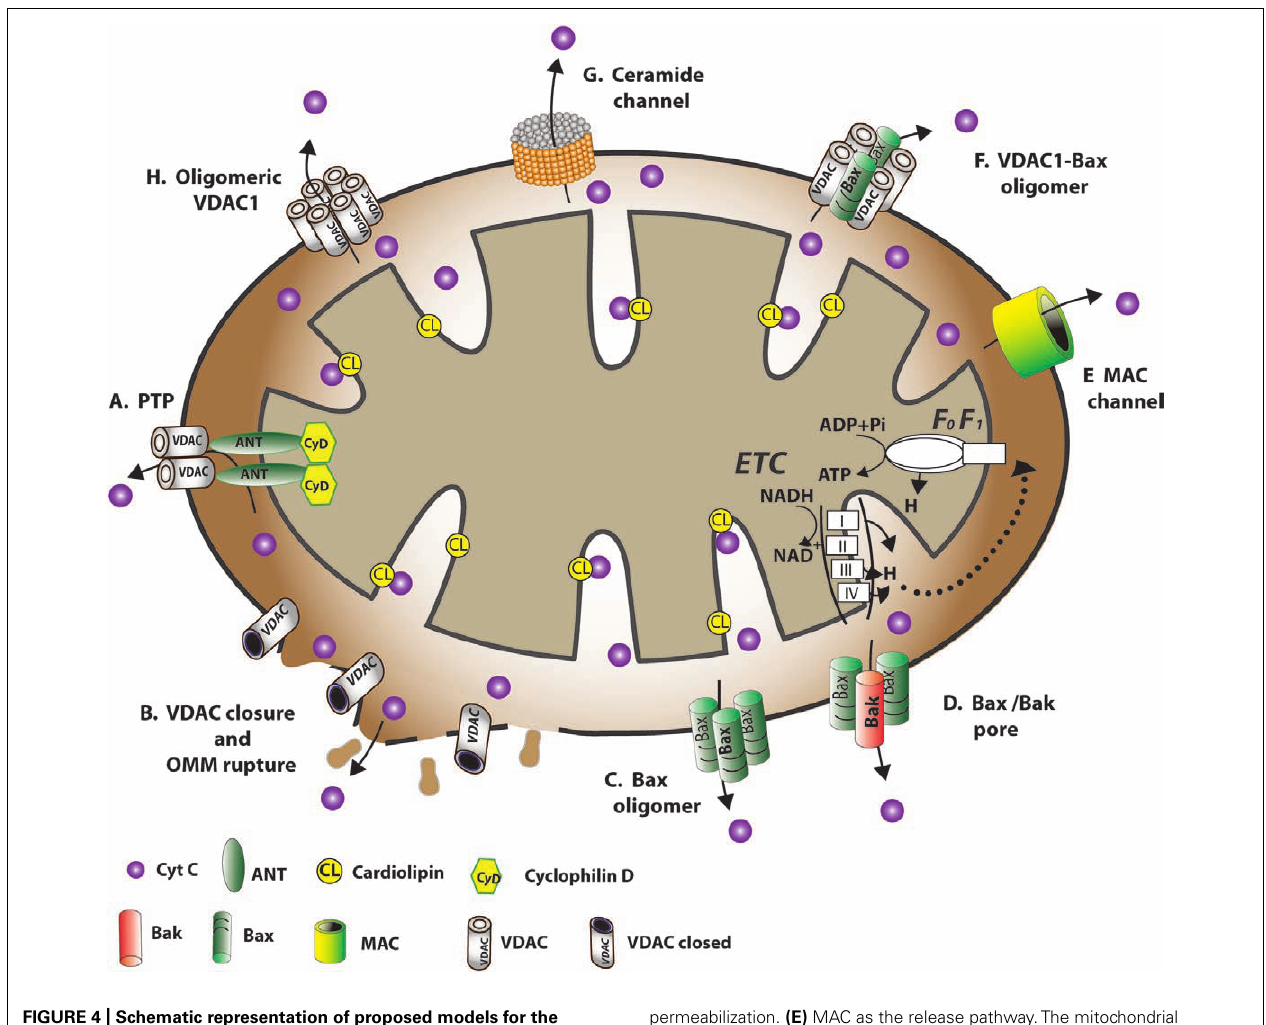
FIGURE 4 | Schematic representation of proposed models for the release of apoptogenic proteins from the mitochondrial inter-membrane space mediating the mitochondrial death decision. Different models explaining how OMM permeability changes during apoptosis induction, allowing the release of apoptogenic factors, such as Cyto c . (A) A permeability transition pore (PTP) provides the apoptogenic proteins release pathway. It is proposed that a large conductance pore-forming complex, the PTP, composed ofVDAC at the OMM, ANT at the IMM and CypD in the matrix, allows apoptogenic protein release. (B) VDAC closure and OMM rupture serves as the cytochrome c release pathway. ProlongedVDAC closure leads to mitochondrial matrix swelling, OMM rupture, and hence, the appearance of a non-specific release pathway for apoptogenic proteins. (C) Bax activation followed by its oligomerization resulting in OMM permeabilization. Upon apoptosis induction, Bax became associated with mitochondria as a large oligomer/complex, forming a Cyto c -conducting channel in the OMM. (D) A pore formed by oligomerized forms of Bax and Bak after their activation by tBID. BH3-only proteins (e.g., Bid) induce oligomerization of Bax/Bak on the OMM, resulting in Bax activation and